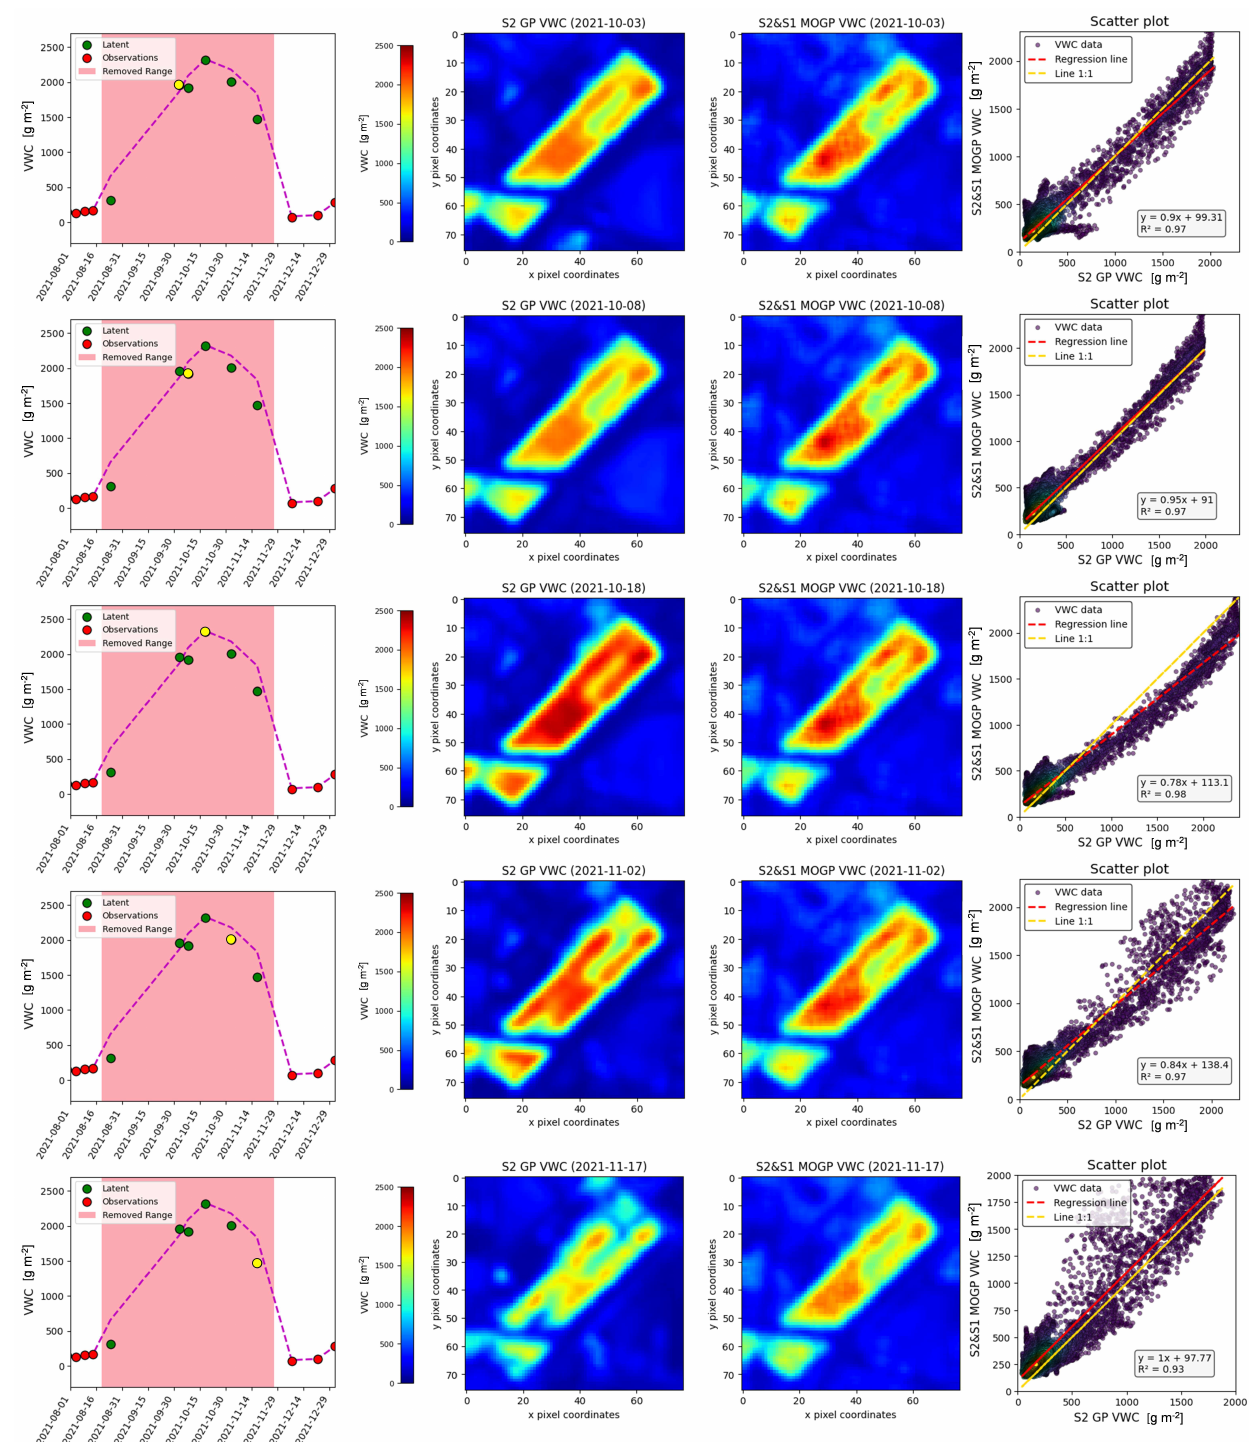
Figure 9. Comparison of S2 GP VWC (original) and S1 & S2 MOGP VWC (reconstructed) maps over a selected subset of the study site (orange-dashed rectangle in Figure 1) corresponding to the artificially removed dates: 2021/10/3, 2021/10/8, 2021/10/18, 2021/11/2, and 2021/11/17 of the winter wheat 2021 phenological cycle. For each assessment date, the position of the extracted samples on the phenological curve (yellow dot), the S2 GP VWC map, the reconstructed S1 & S2 MOGP VWC map and the scatterplot between the original and reconstructed VWC maps are